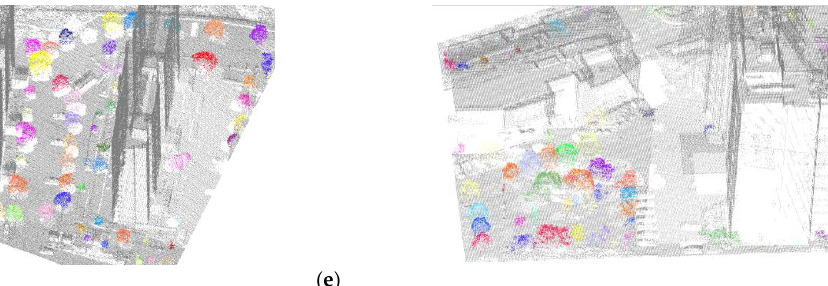
Figure 12. Generalization result on ALS point cloud. ( a ) Raw point cloud, ( b ) semantic segmentation result, dotted in different colors according to the labels, ( c ) tree extraction result, where green and gray points represent points from trees and non-tree objects, respectively, ( d ) individual tree segmentation result, dotted in different colors, ( e ) close-up for individual tree segmentation. Table 4. Instance-level quantitative evaluation on ALS point clouds. Best results in bold. Prec (%) Rec (%) mCov (%) mWCov (%) SGE_Net [64]